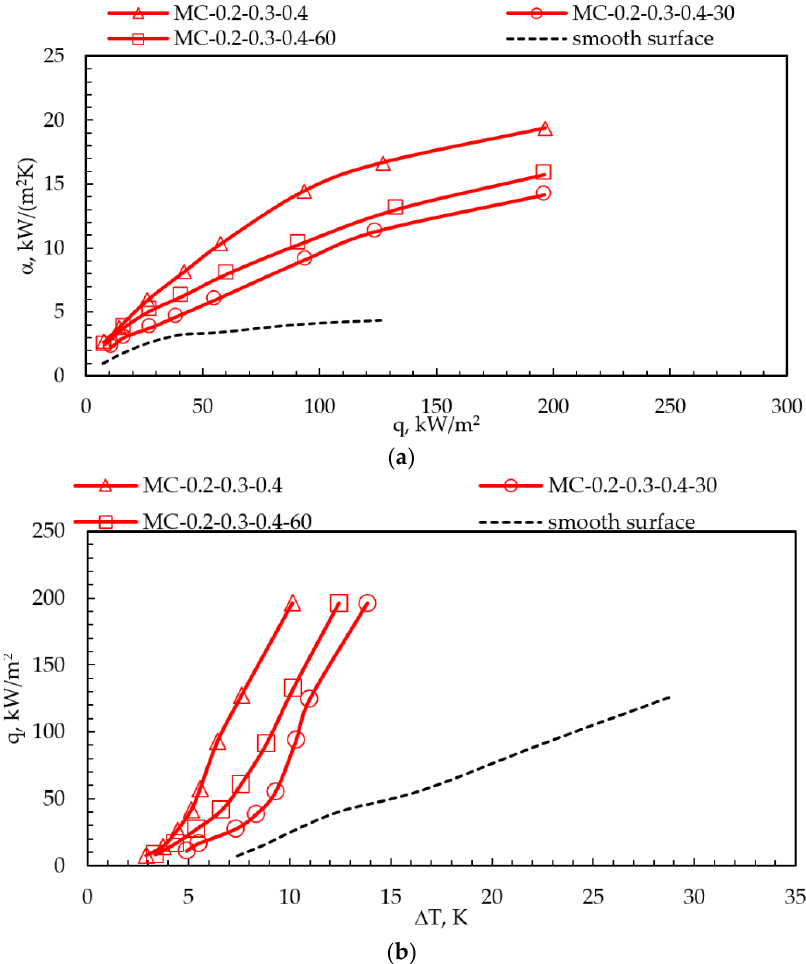
Figure 5. Pool boiling curves for NOVEC-649, width of microchannel 0.2 mm. ( a ) Pool boiling heat transfer; ( b ) boiling curves.